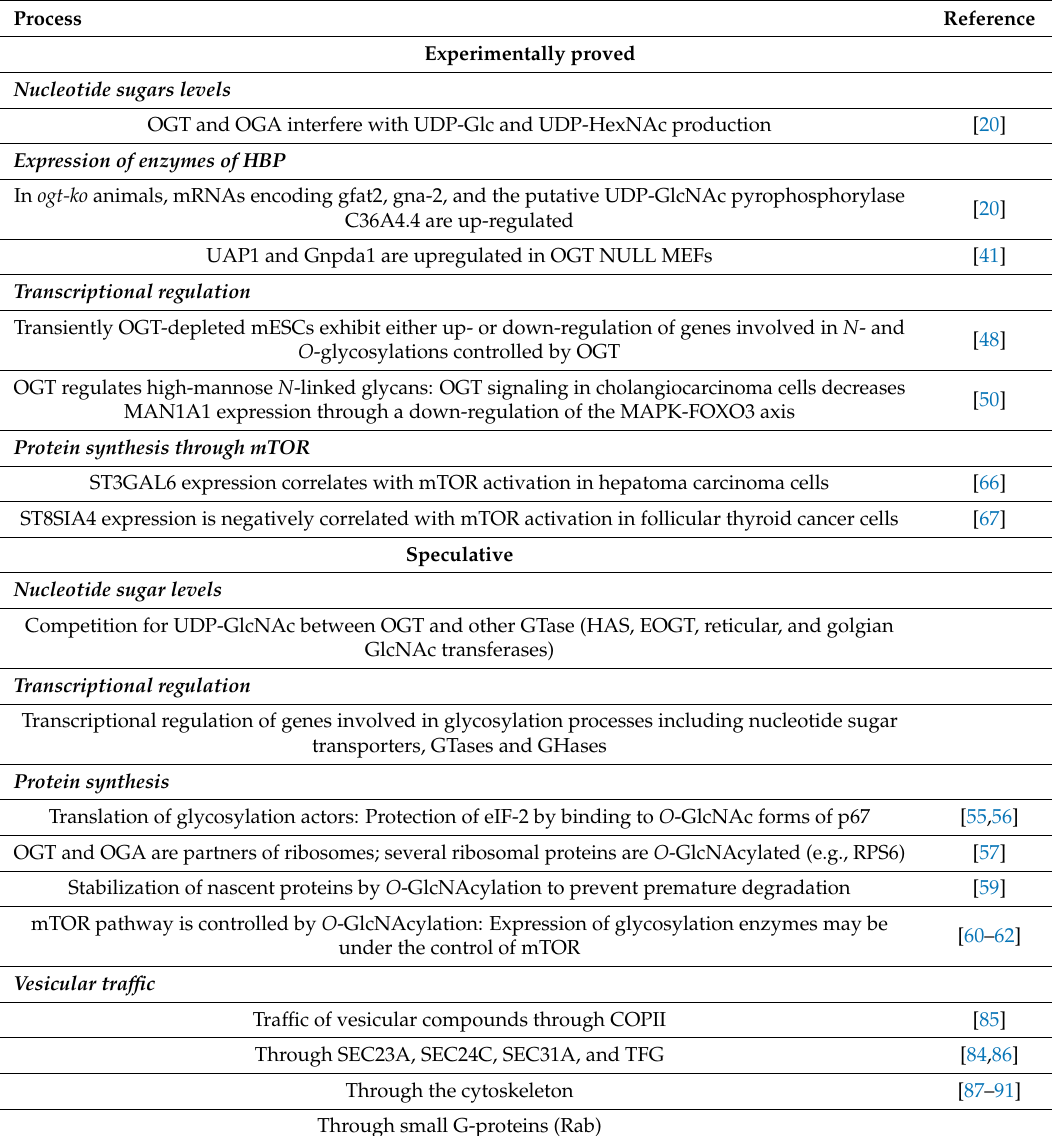
Table 3. Main experimental evidences and speculations arguing for the regulation of complex glycosylations by O